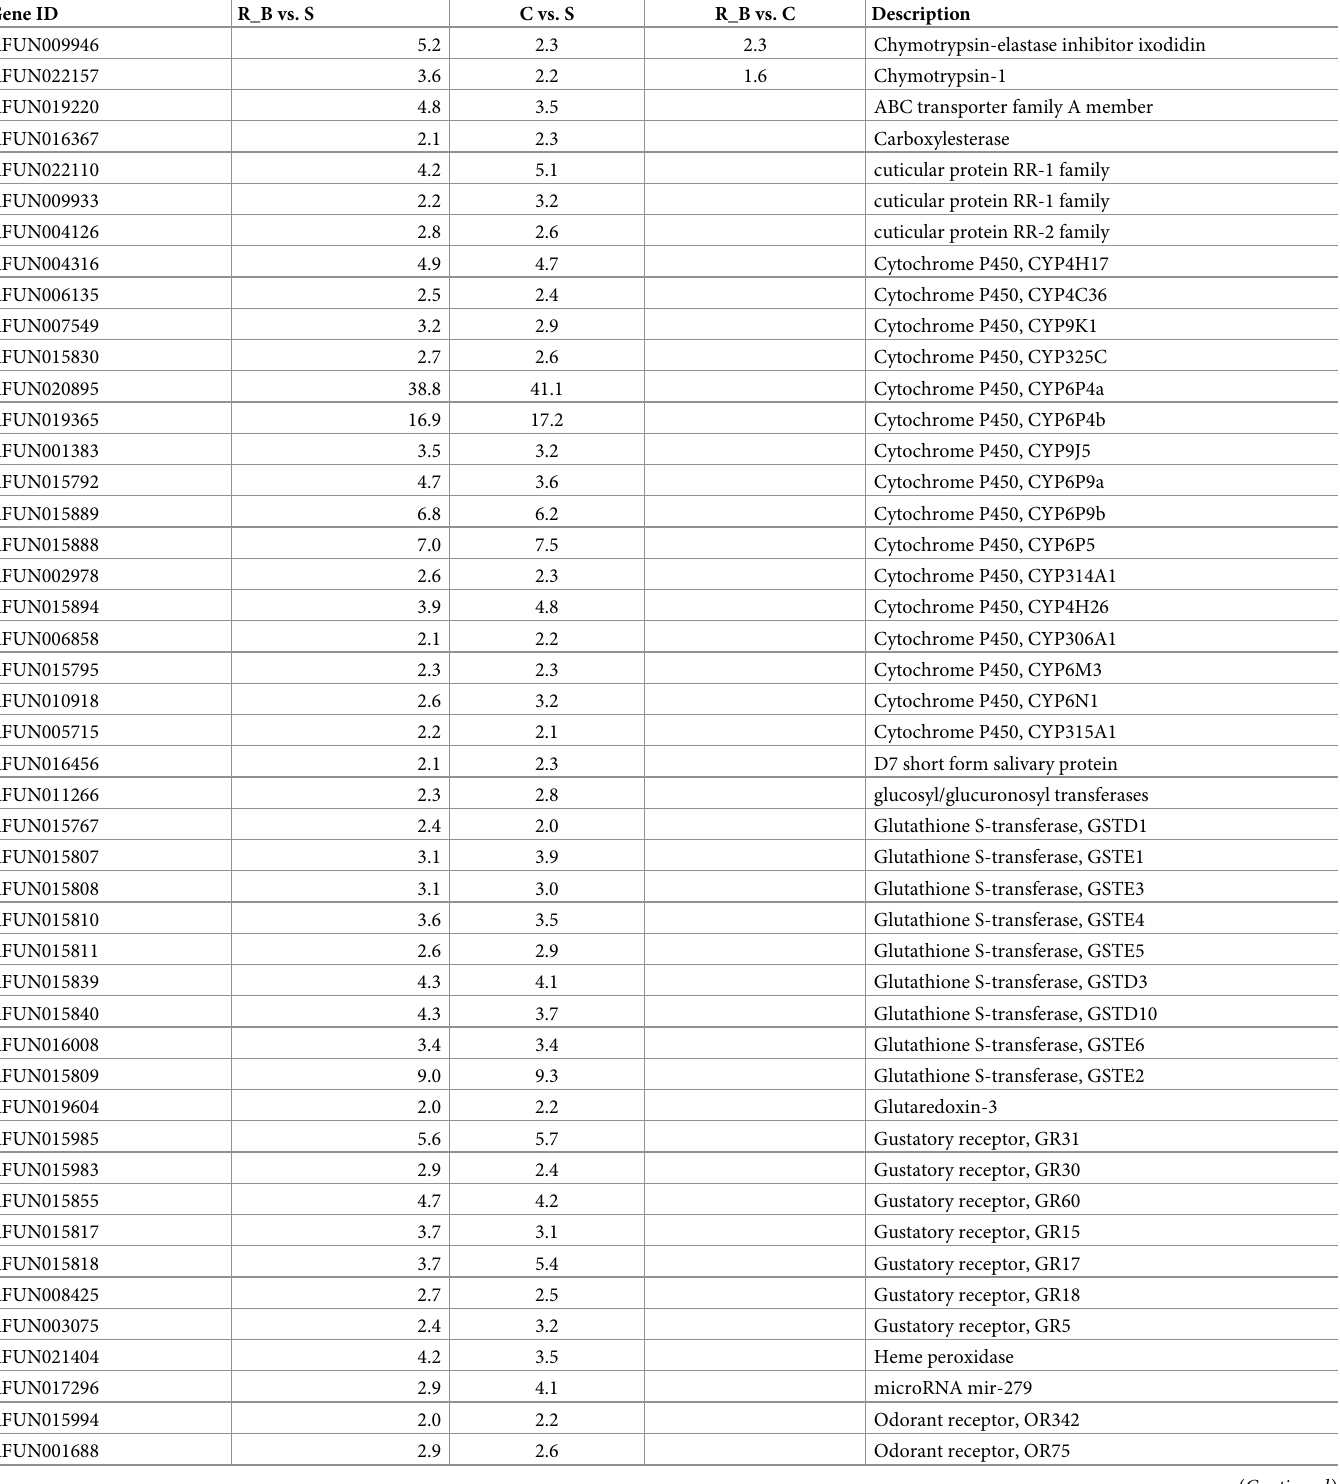
Table 2. List of resistance associated transcripts commonly over-expressed between bendiocarb resistant (R), unexposed An . funestus (C) from Ghana and the FANG susceptible (S) strain at fold-change > 2 (or 1.5 for R vs. C) FDR <